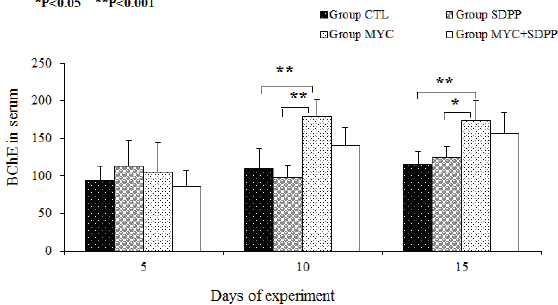
Figure 2 - effect of mycotoxins and spray-dried porcine plasma (SDPP) on BChe activity in serum (µmol BuSCh/h/ mg of protein) of piglets (experiment I). Ctl group: control diet; SDPP group: control diet and supplementation with 6% of SDPP; MYC group: 210 µg/kg aflatoxins and 6.690 µg/kg fumonisins; MYC+SDPP group: 253 µg/kg aflatoxins, 6.930 µg/kg of fumonisins and 6% SDPP. Bars represent means ± standard deviation. *Comparison among the four groups, in each separate period of the experiment (ANOVA followed by the Duncan test). One asterisk (*) or two asterisk (**) illustrates the difference between groups in the probability of <0.05 and <0.001, respectively.